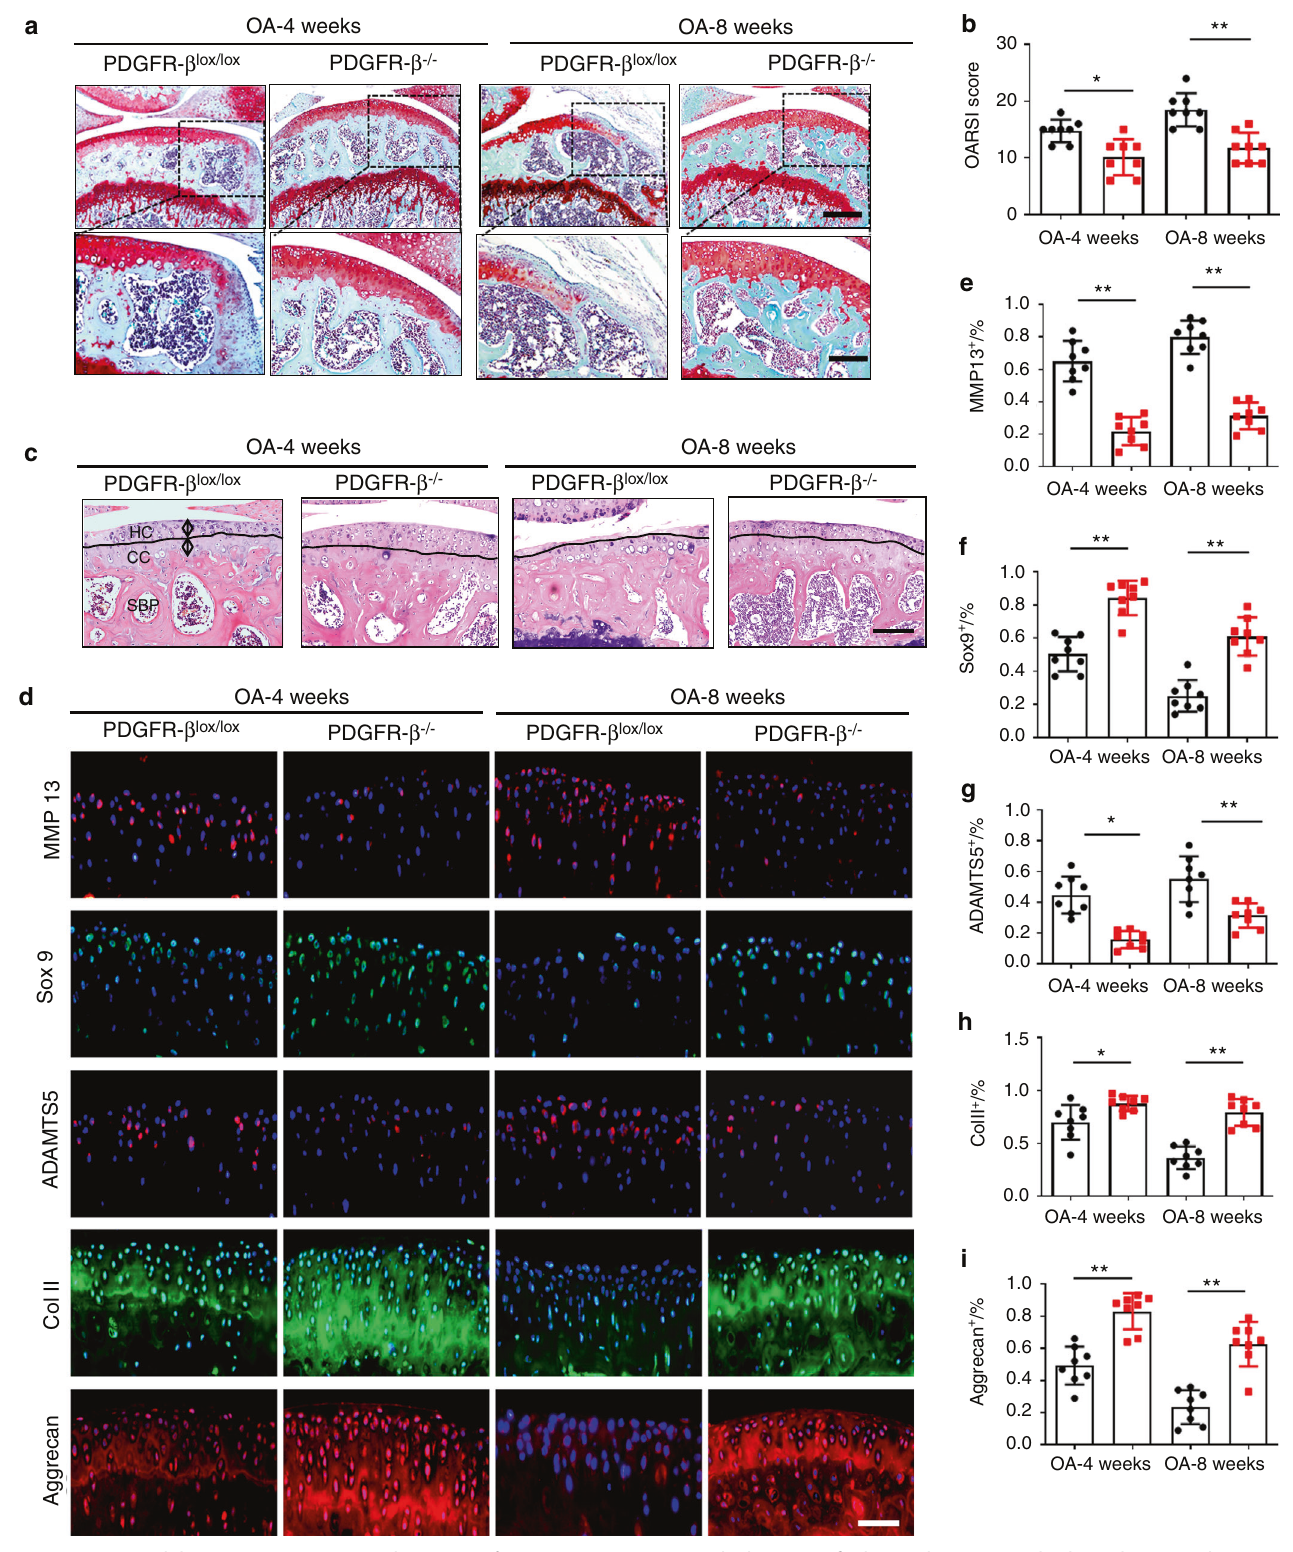
Fig. 3 PDGFR- β deletion in ECs prevents the onset of OA. a SOFG (upper) with the magni fi ed area (bottom) in the boxed area in the upper image of articular cartilage in the PDGFR- β lox/lox and PDGFR- β − / − mice at 4 weeks and 8 weeks post-ACLT; bone (green) and proteoglycan (red). Scale bar, top 100 µm; bottom 50 µm. b OARSI-modi fi ed Mankin scores of cartilage in the PDGFR- β lox/lox and PDGFR- β − / − mice at 4 weeks and 8 weeks post-ACLT. n = 8. c H&E staining where calci fi ed cartilage (CC) and hyaline cartilage (HC) are separated by black dashed lines in the PDGFR- β lox/lox and PDGFR- β − / − mice at 4 weeks and 8 weeks post-ACLT. Scale bars, 50 μ m. d – i Immuno fl uorescence staining and quanti fi cation of MMP-13, Sox9, ADAMTS 5, Col II, and aggrecan in articular cartilage from the PDGFR- β lox/lox and PDGFR- β − / − mice at 4 weeks and 8 weeks post-ACLT. n = 8. Scale bar, 50 µm. * P < 0.05 and ** P < 0.01 compared to the PDGFR- β lox/lox controls or as denoted by